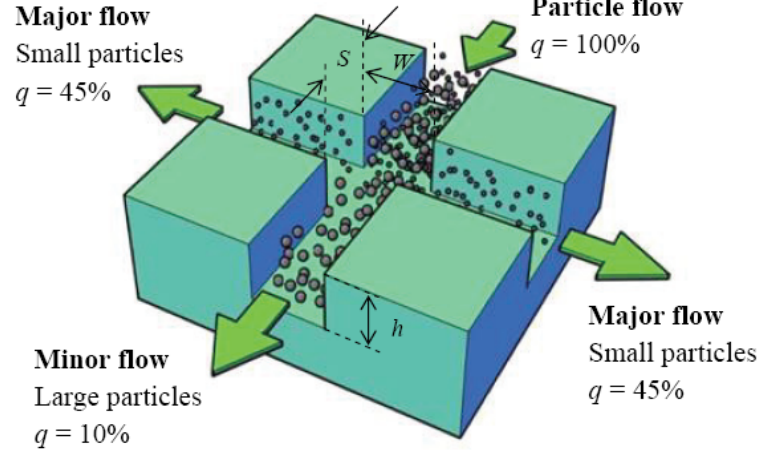
Figure 2. Schematic of the virtual impactor. The large particles follow the minor flow due to larger inertial force. The small particles follow the major flow to the other channels. q denotes the percentage of the total